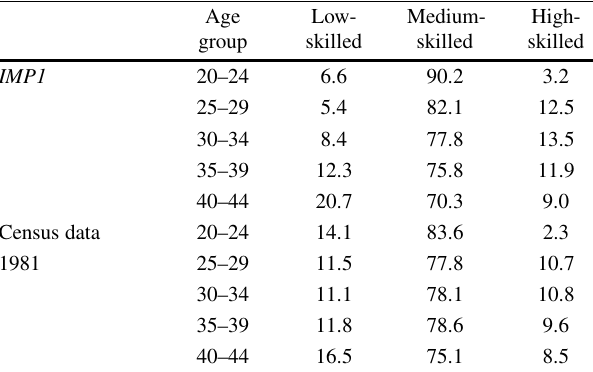
Table 9 Qualification structure by age groups –